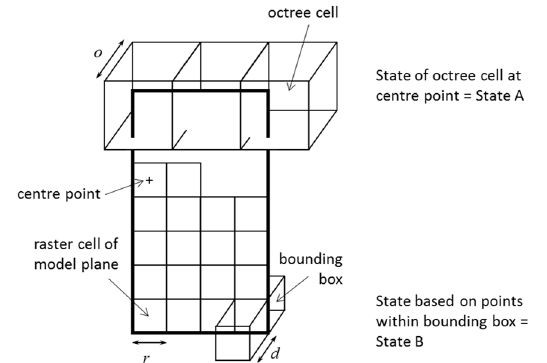
Figure 2. Schematic depiction of a model plan with octree cells (used for determination of state A) and raster cells (used for determination of state B and for the combination of A and